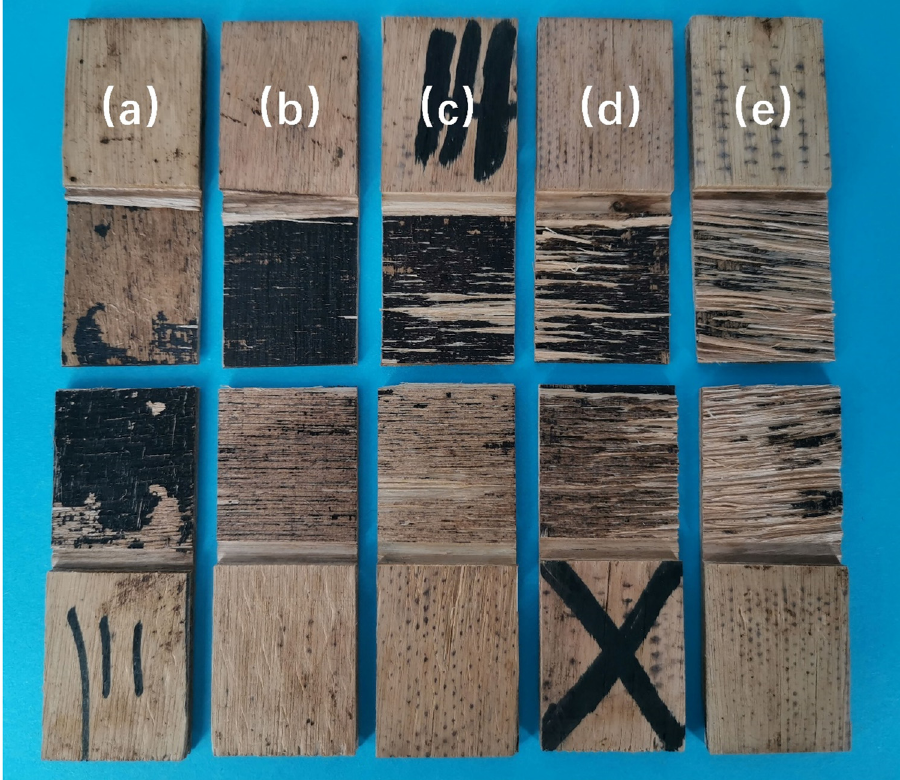
Figure 7: In fl uences of ECH on the wood failure of the wet plywood: ( a ) GKLE - 10, ( b ) GKLE - 20, ( c ) GKLE - 30, ( d ) GKLE - 40, and ( e ) GKLE -